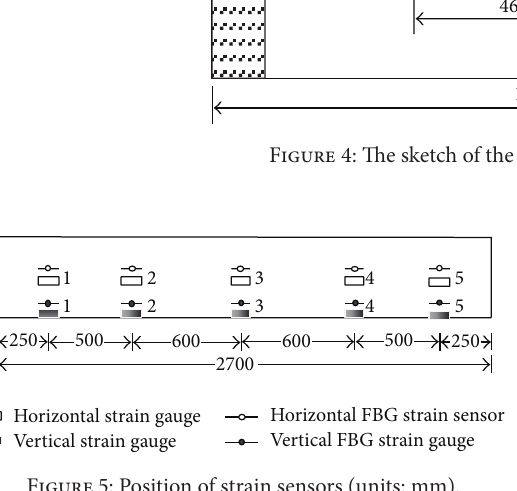
Figure 5: Position of strain sensors (units: mm).